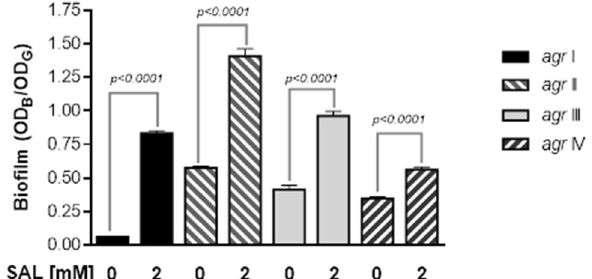
Figure 4. SAL promotes biofilm formation among S. aureus strains of agr types I to IV. Biomass quantification of the biofilms generated by the S. aureus BRA ( agr I), CBS ( agr II), MW2 ( agr III) and RN8540 ( agr IV) strains formed for 24 h at 37 °C in the presence or absence of 2 mM of SAL. Each bar represents the mean ± SEM from 4 independent experiments with 8 wells for each condition. Statistical analysis was performed with the Mann– Whitney test.